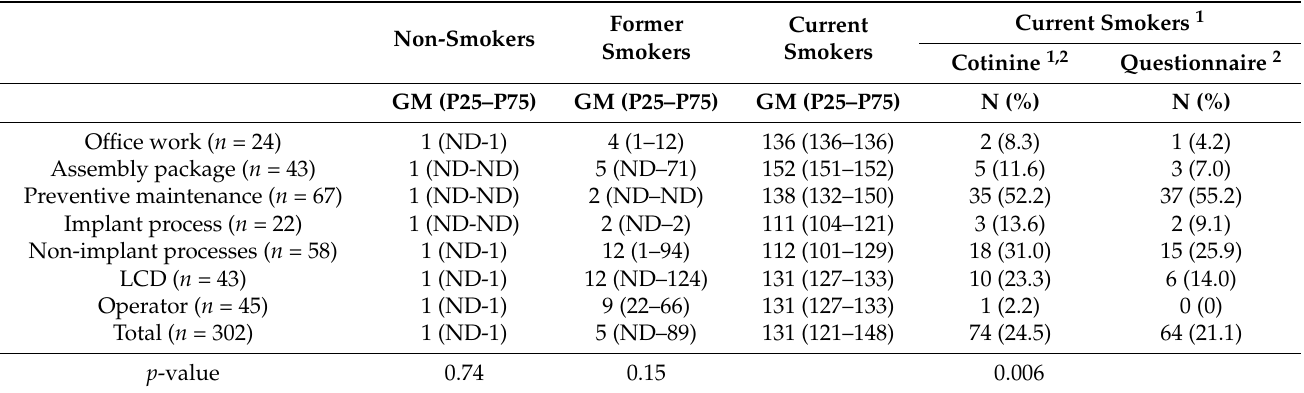
Table 2. Geometric mean and detection rate of urinary cotinine in current smokers among semicon- ductor